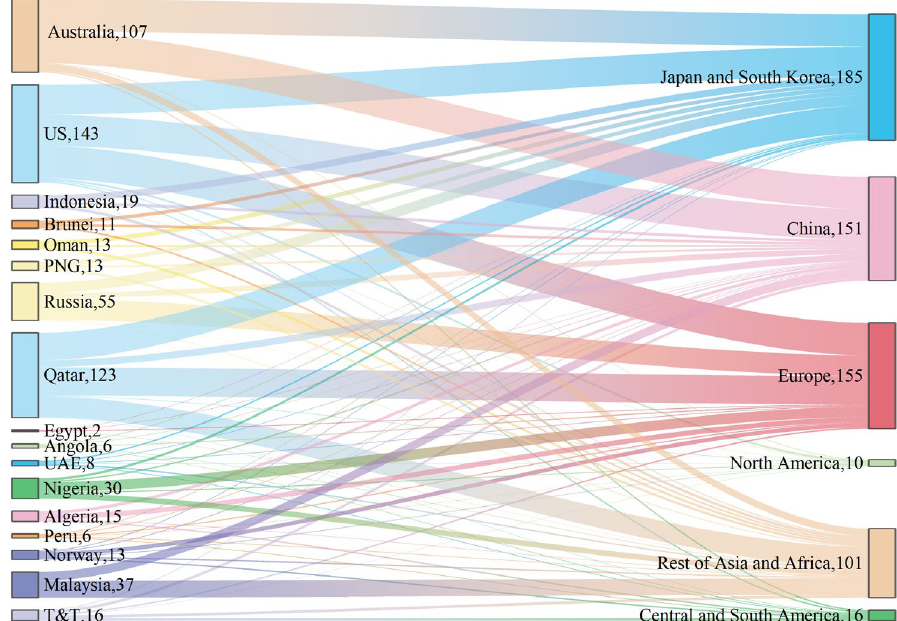
Figure 5. LNG trade strategy in 2030 at risk minimization (Figures represent the total volume of imports or exports in BCM).